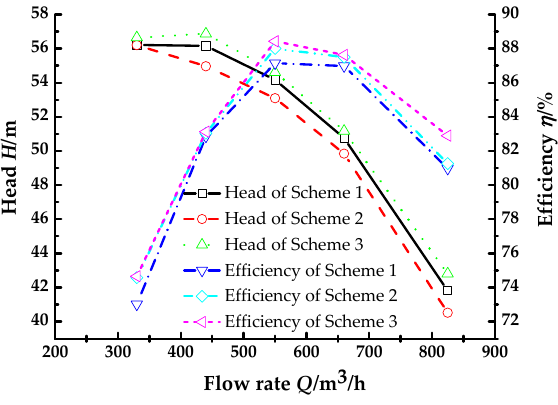
Figure 16. Hydraulic performances of the centrifugal pump with different blade wrap angles.